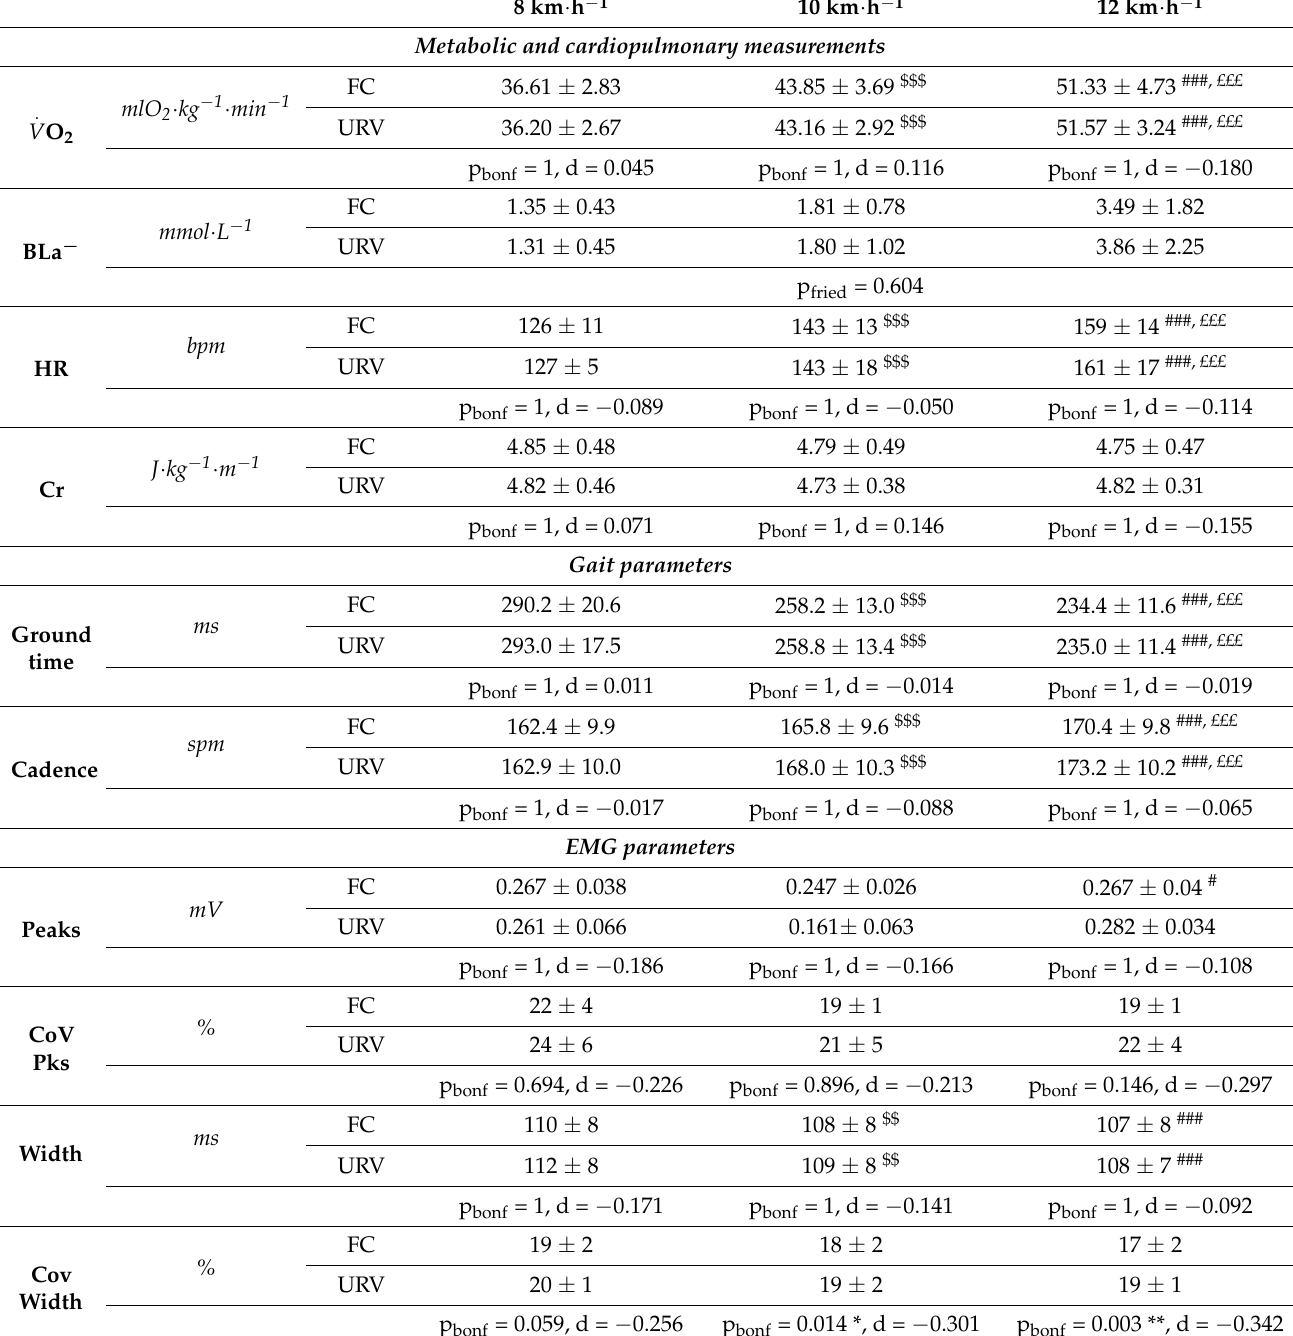
Table 2. Metabolic measurements, gait and psychological parameters divided by running condition and speed. 8 km · h − 1 Metabolic and cardiopulmonary